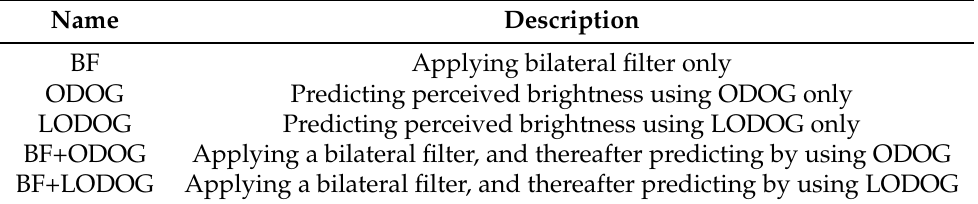
Table 2. Names and descriptions of filters used for